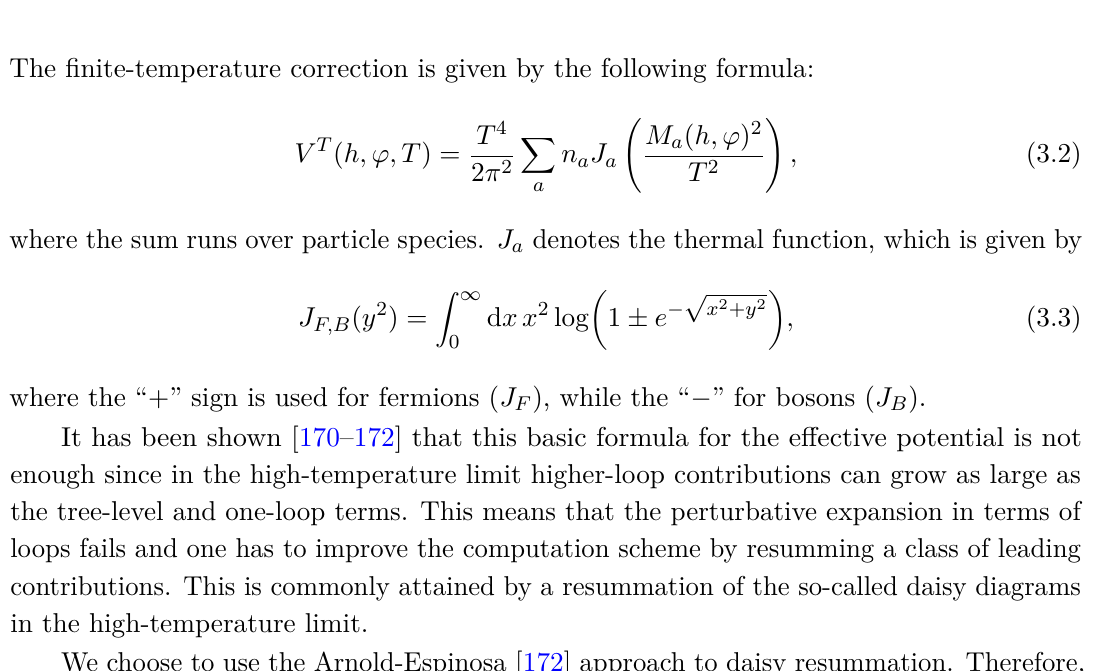
Figure 3 . Values of the new scalar mass M S (left panel) and the VEV w (evaluated at µ = M X ) (right panel). In the left panel the thick black line indicates where M this line mass ordering between S and H changes (to the left of the line M M H < M S ). To the right of the dotted line ξ H becomes numerically equal to 1. The dashed lines indicate discrepancy between the running and the pole mass (in percent). Grey shaded regions are excluded, see caption of figure